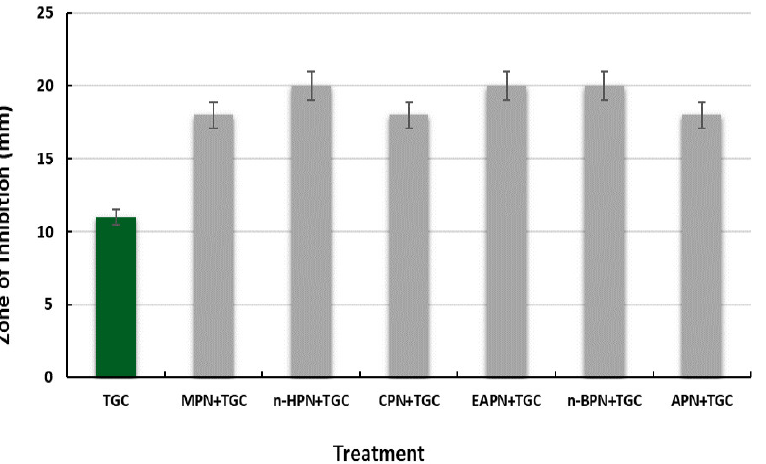
Figure 11. Antibiotic reversal activity of P. nigrum extracts in combination with ciprofloxacin (5 μg) for S. typhi .